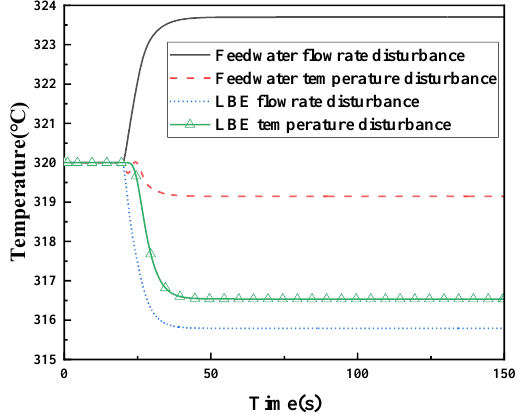
Figure A1. LBE outlet temperature variation under different step disturbances.